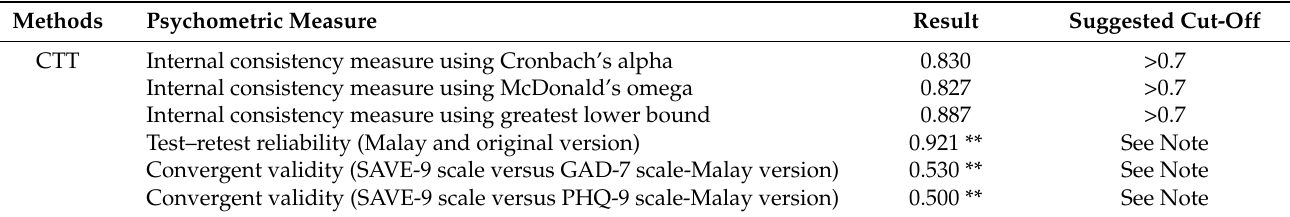
Table 5. Psychometric properties for the Malay version of the SAVE-9 scale at the scale level ( n = 203).